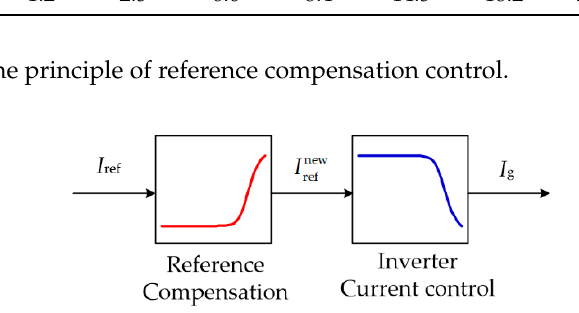
Figure 7. Schematic diagram of reference compensation.